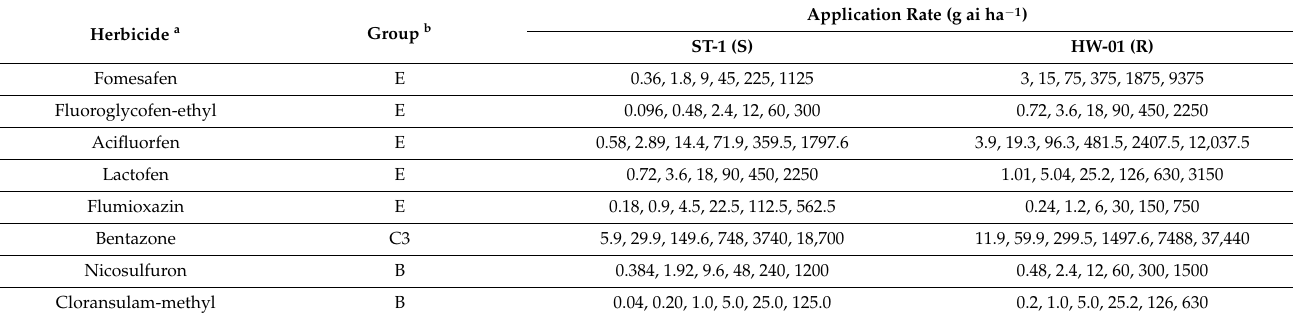
Table 1. Herbicide rates applied in the whole-plant